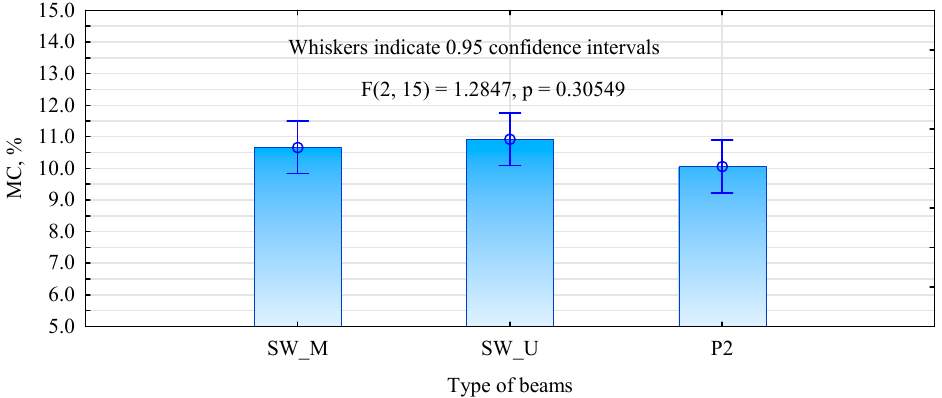
Figure 8. Moisture content (MC) of the beams during the bending test evaluation. The obtained static bending strength values were also subjected to ANOVA analysis. The test results indicate no statistically significant differences in this property in the fabricated beams (Figure 9).